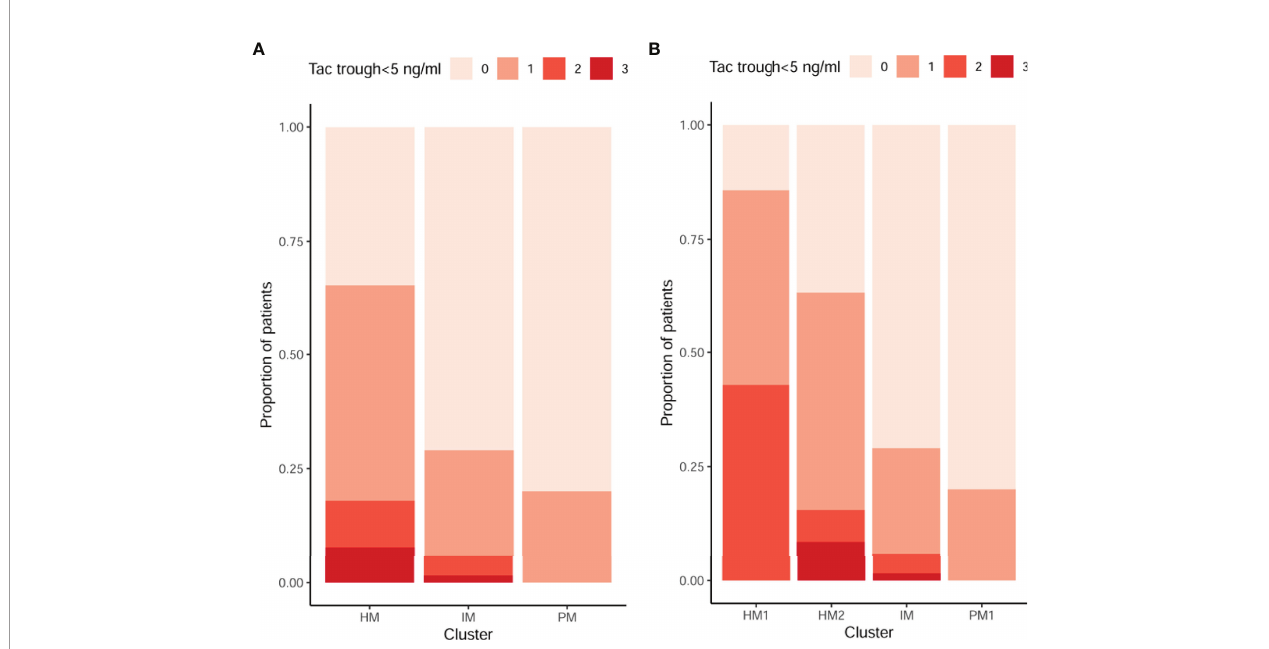
FIGURE 3 | Proportion of TAC underexposure (<5 ng/ml) according to different CYP3A clusters. 0, 1, 2, and 3 in the legend represent the number of times that patients were off target. (A) There were a higher proportion of patients with TAC trough levels below 5 ng/ml among HM as compared to IM and PM at mean time of BPAR occurrence or before BPAR. The frequencies of patients with low levels at least once in this follow-up period were 20%, 29%, and 69% in the PM, IM, and HM groups, respectively (p < 0.001). (B) There were a higher proportion of patients with TAC trough levels below 5 ng/ml among HM1 and HM2 as compared to IM and PM1 at mean time of BPAR occurrence or before BPAR. The frequencies of patients with low levels at least once in this follow-up period were 20%, 29%, 63%, and 86% in the PM, IM, HM2, and HM1 groups, respectively (p < 0.001). TAC, tacrolimus; HM, high metabolizers; IM, intermediates; PM, poor metabolizers; BPAR, biopsy-proven acute